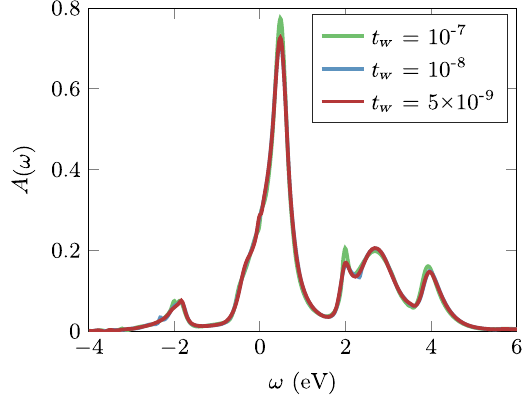
FIG. 12. Different truncation values t not influence the shape of the spectrum A ð ω Þ .